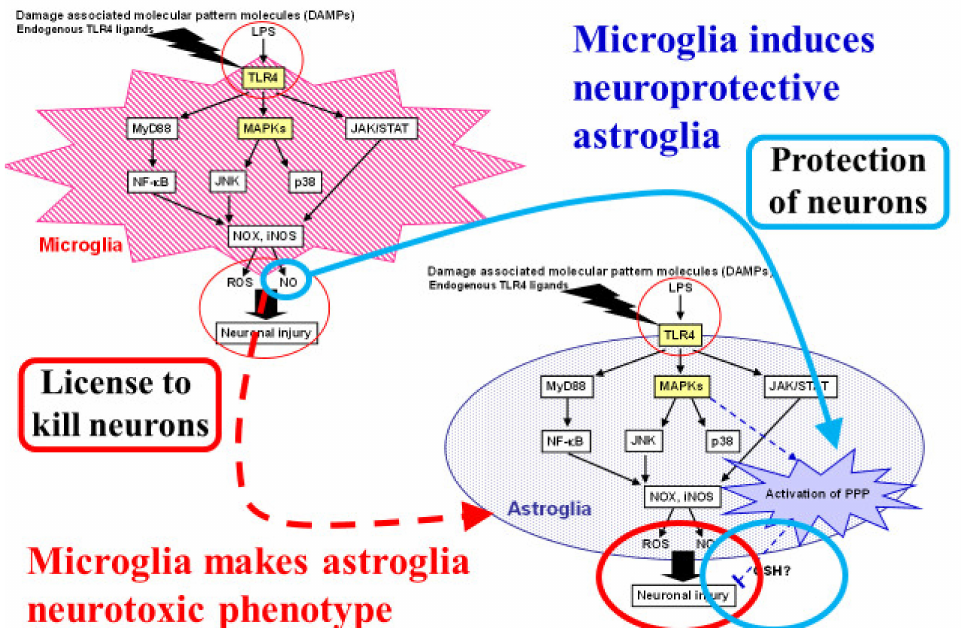
Figure 5. Dual roles of microglia that induce both proinflammatory-neurotoxic and anti-inflammatory-neuroprotective astrocytes. Astrocytes are known to play neurotoxic roles in ischemic stroke as well as neurodegenerative diseases. Microglia induce neurotoxic astrocytes through proinflammatory responses induced by toll-like receptor (TLR) 4 activation. Reactive oxygen species (ROSs) and nitric oxide (NO) also act as neurotoxic molecules that can cause neuronal injury. We focused on the neuroprotective roles of astrocytes through their high glycolysis activity and the pentose-phosphate pathway (PPP) against oxidative stress. Damage-associated molecular patterns (DAMPs) and lipopolysaccharide (LPS), a natural TLR4 ligand, induce ROS and NO production in microglia. We found that NO released from microglia activated astroglial PPP flux through the Kelch-like enoyl-CoA hydratase-associated protein 1 (Keap1)/nuclear factor erythroid 2 p45 subunit-related factor 2 (Nrf2) system. Namely, the NO-induced nitrosylation of Keap1 residues released Nrf2 from Keap1, allowing Nrf2 to act as a transcription factor in an in vitro model of cultured rodent microglia and